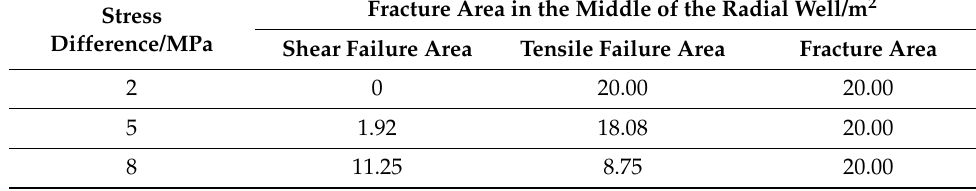
Table 7. Quantitative characterization of the fracture morphology on the X - Y plane under variable stress